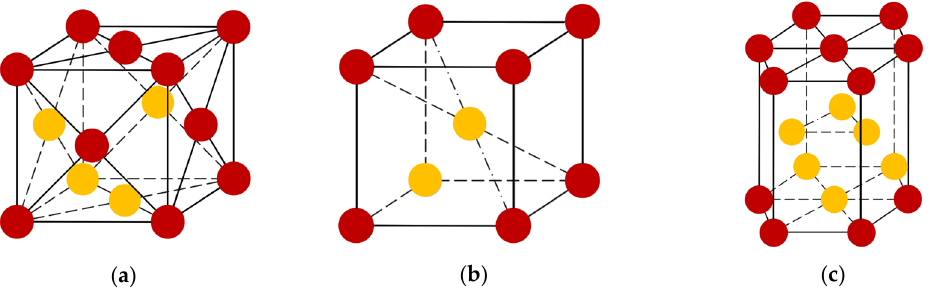
Figure 1. Crystal phase of Fe-SMA [32]: ( a ) γ -austenite (fcc), ( b ) α ′ -martensite (bct), ( c ) ε -martensite (hcp). Fe-SMA is divided into two different groups based on material properties [36]. The first group of Fe-SMA is thermoelastic martensite alloys, including Fe-Pt [37], Fe-Pd [38,39], and Fe-Ni-Co [40,41], whose typical characteristics are similar to NiTi-SMA. The martensite transformation is the crystal lattice changes between fcc ( γ -austenite) and bct ( α ′ -martensite). The first group alloys possess the ability of SE (or pseudoelasticity), but with a narrow thermal hysteresis, its SME is limited by temperature when used for structural reinforcement. The sec- ond group of Fe-SMA contains alloys such as Fe-Ni-C [42] and Fe-Mn-Si [43,44]. This group